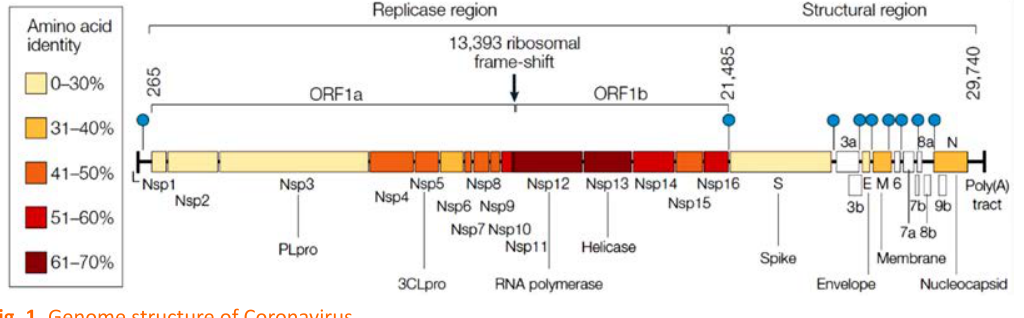
Fig. 1. Genome structure of Coronavirus Reproduced with permission from [10]